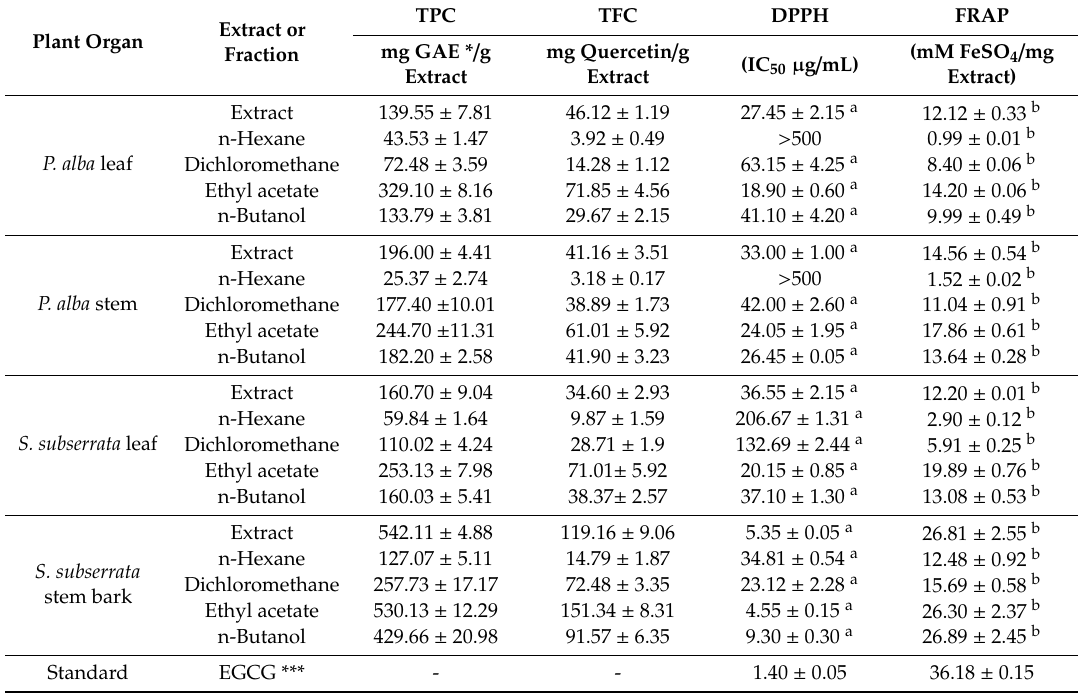
Standard * Gallic acid equivalent. Values are mean ± standard deviation (SD) of three independent experiments. *** Epigallocatechin gallate. a p < 0.05 significantly di ff erent from EGCG (DPPH). b p < 0.05 significantly di ff erent from epigallocatechin gallate (EGCG)